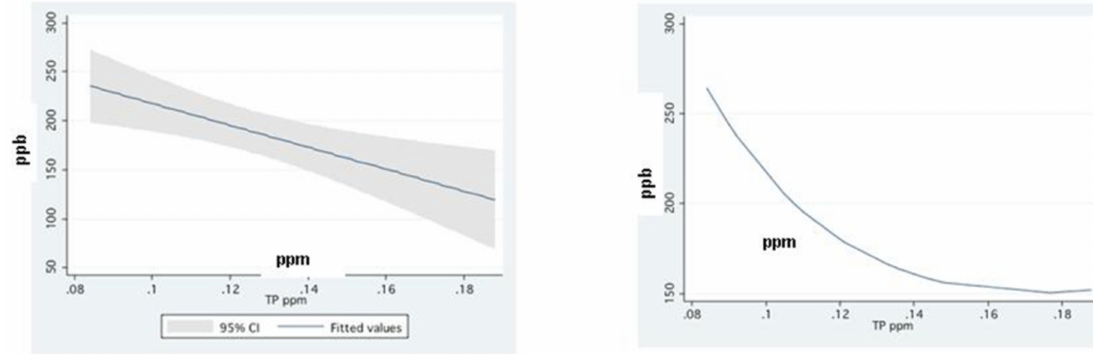
Figure 6. Relationship between annual (1993–2018) mean concentrations in the Lake Agmon outflow (ppb) and River Jordan waters (ppm). Left : linear regression (95% CI). Right : fractional polynomial